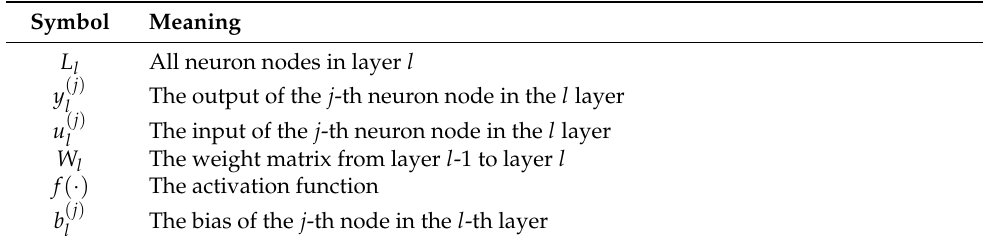
Table 1. Symbols in the network